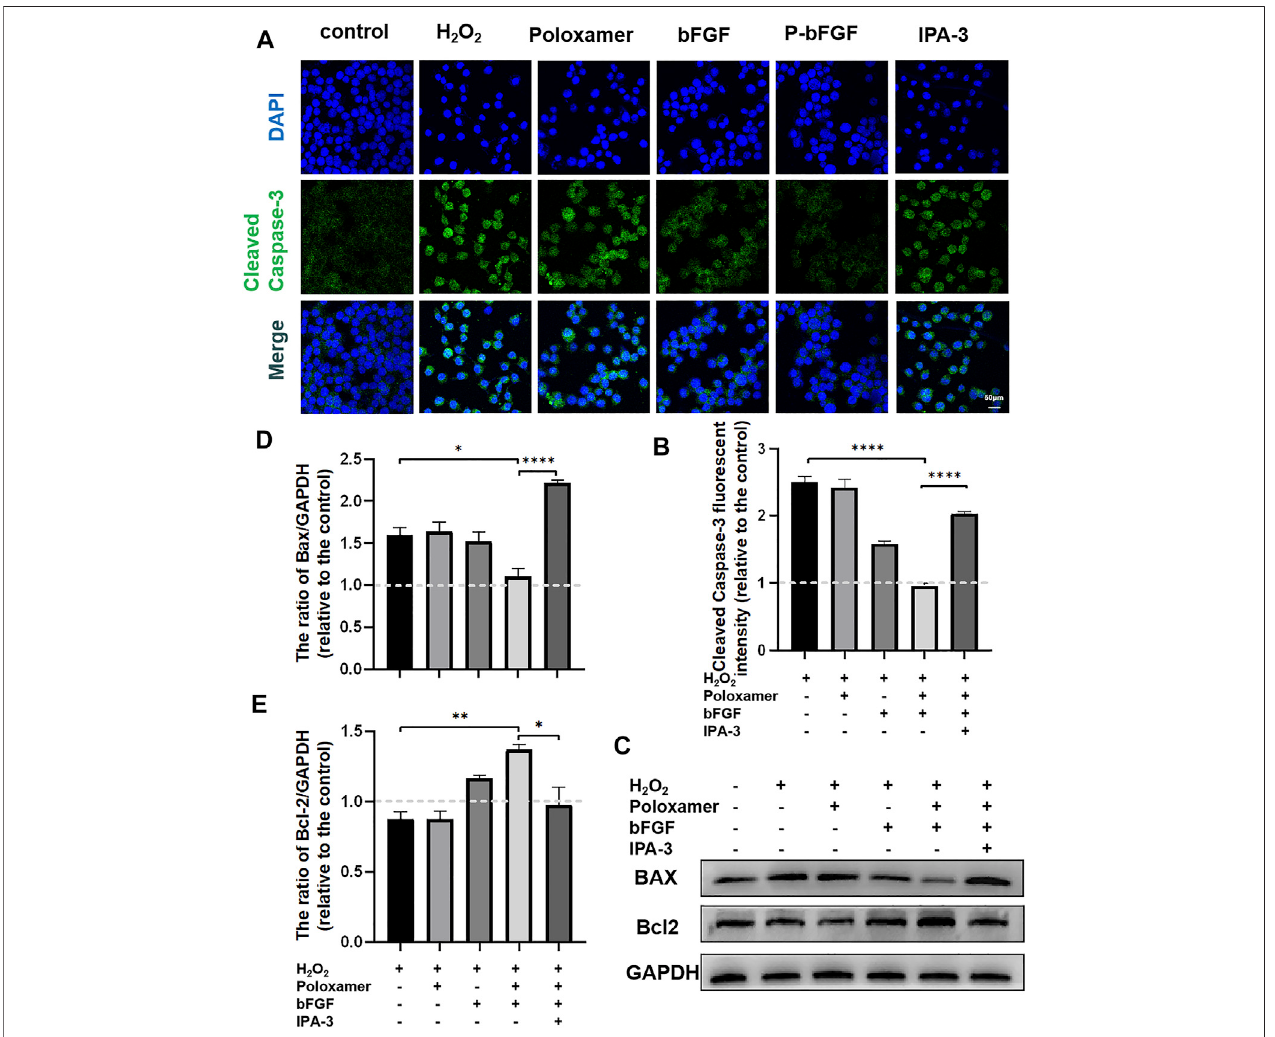
FIGURE 6 | P-bFGF activated PAK1 and inhibited the apoptosis of SCs. (A) Representative immuno fl uorescence staining of Cleaved Caspase-3 of SCs after treatment;scalebar=50 μ m. (B) QuantitativecalculationofthemeanofCleavedCaspase-3 fl uorescence.Thedatawereexpressedasmean±SEM( n =4);H 2 O 2 group vs. P-bFGF group: **** p < 0.0001, P-bFGF group vs. IPA-3 group: **** p < 0.0001. (C) Representative western blot images of the BAX and Bcl2 expression in SCs after treatment. (D) Quanti fi cation of the levels of the BAX protein; H 2 O 2 group vs. P-bFGF group: * p < 0.05, P-bFGF group vs. IPA-3 group: **** p < 0.0001. (E) Quanti fi cation of the levels of the Bcl2 protein; H 2 O 2 group vs. P-bFGF group: ** p < 0.01, P-bFGF group vs. IPA-3 group: * p < 0.05. The data above were expressed as mean ± SEM ( n = 3). A dashed line at 1.0 represented control group.